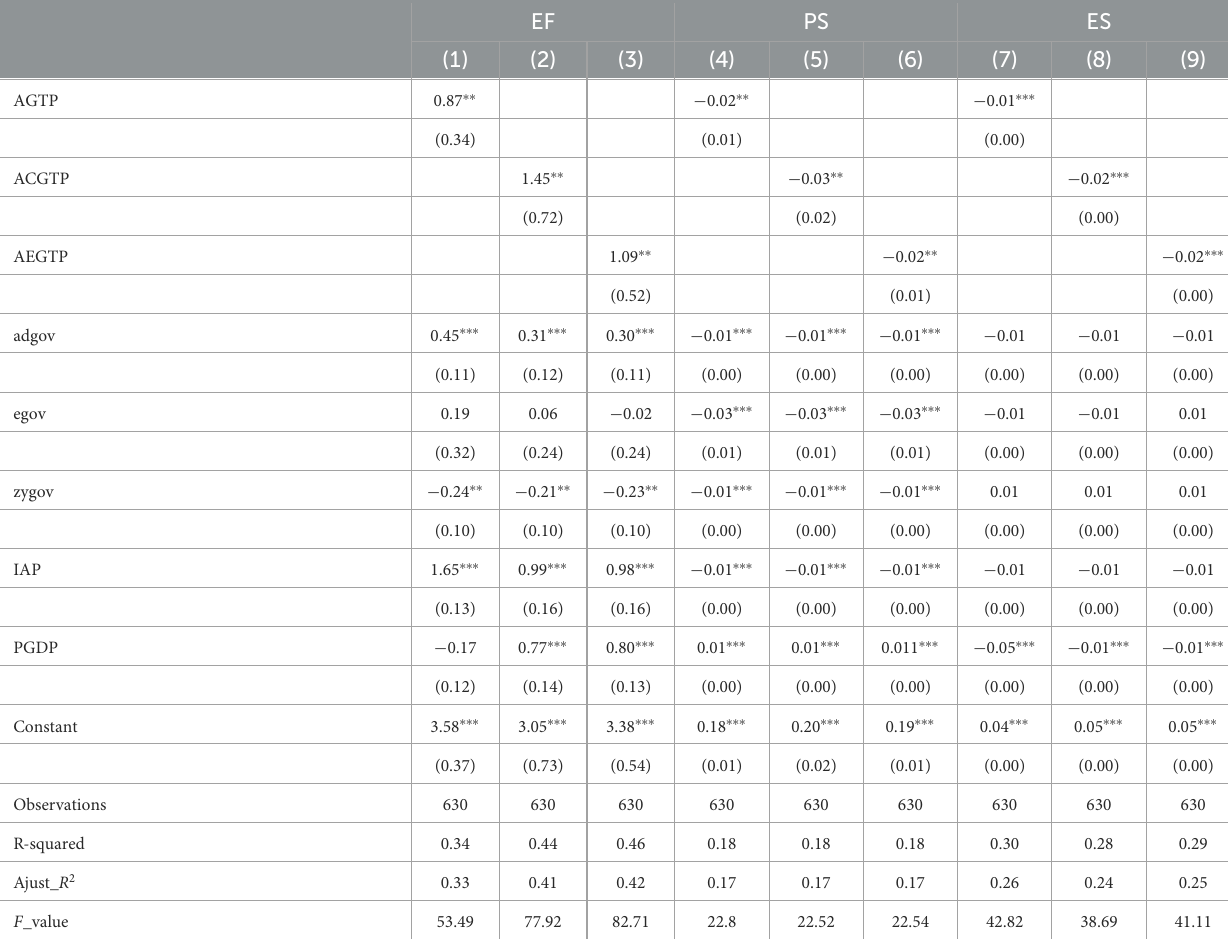
TABLE 2 Empirical results of green technological advancement on intermediary